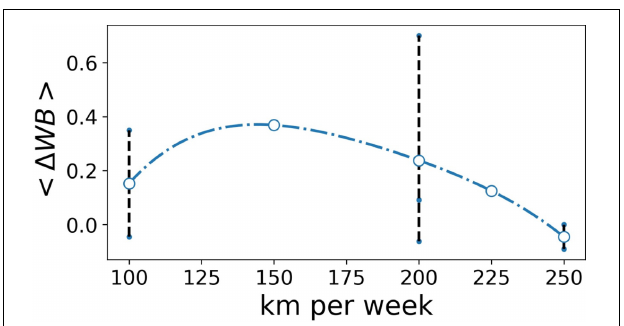
FIGURE 2 | Averaged change in well-being ( <(cid:49) WB > ) as a function of weekly training load (km week - 1 ). Blue circles represent change in well-being averaged on cyclists covering the same distance per week. The small blue points and the dotted lines represent individual change in WB.